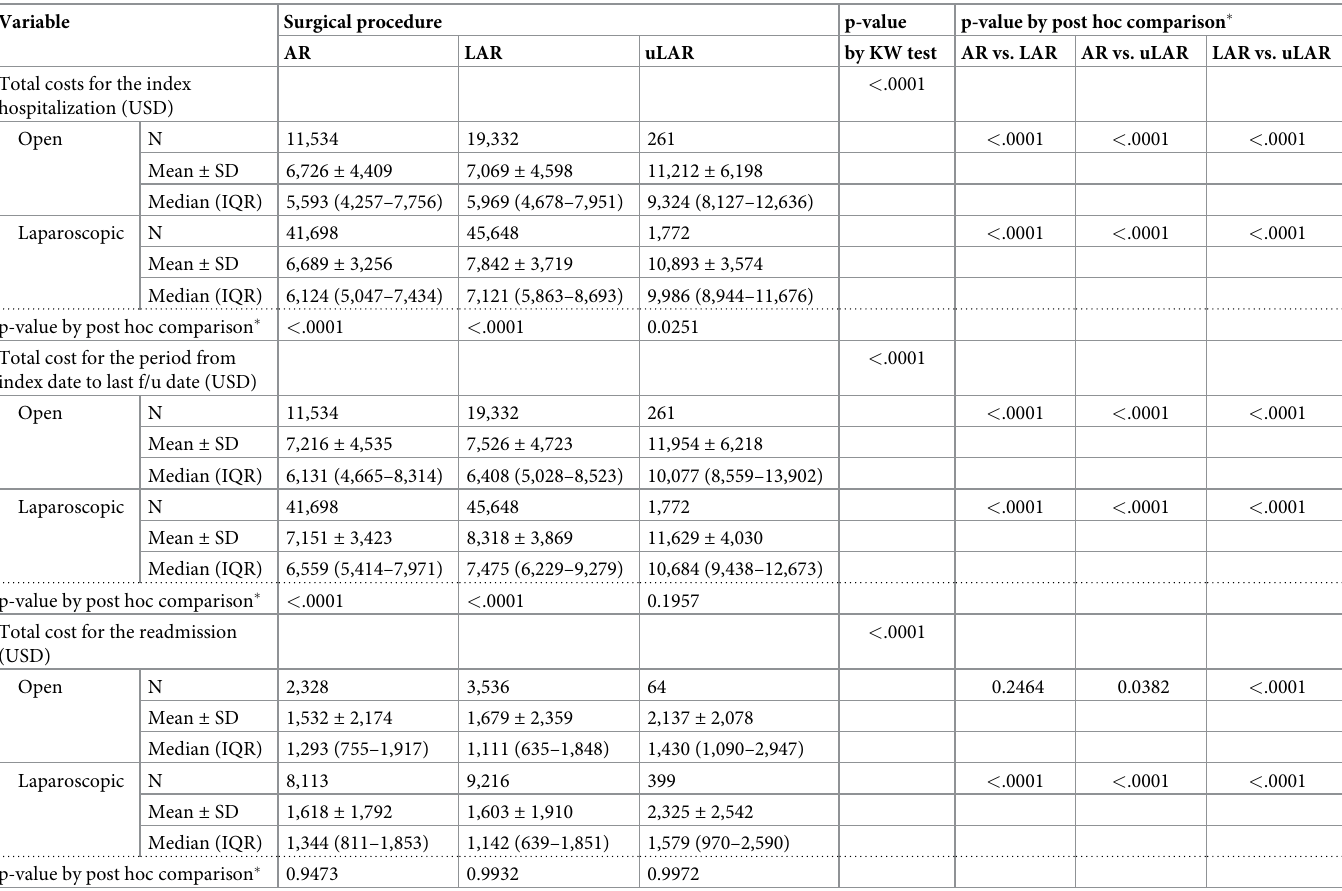
Table 4. Healthcare costs by procedure &